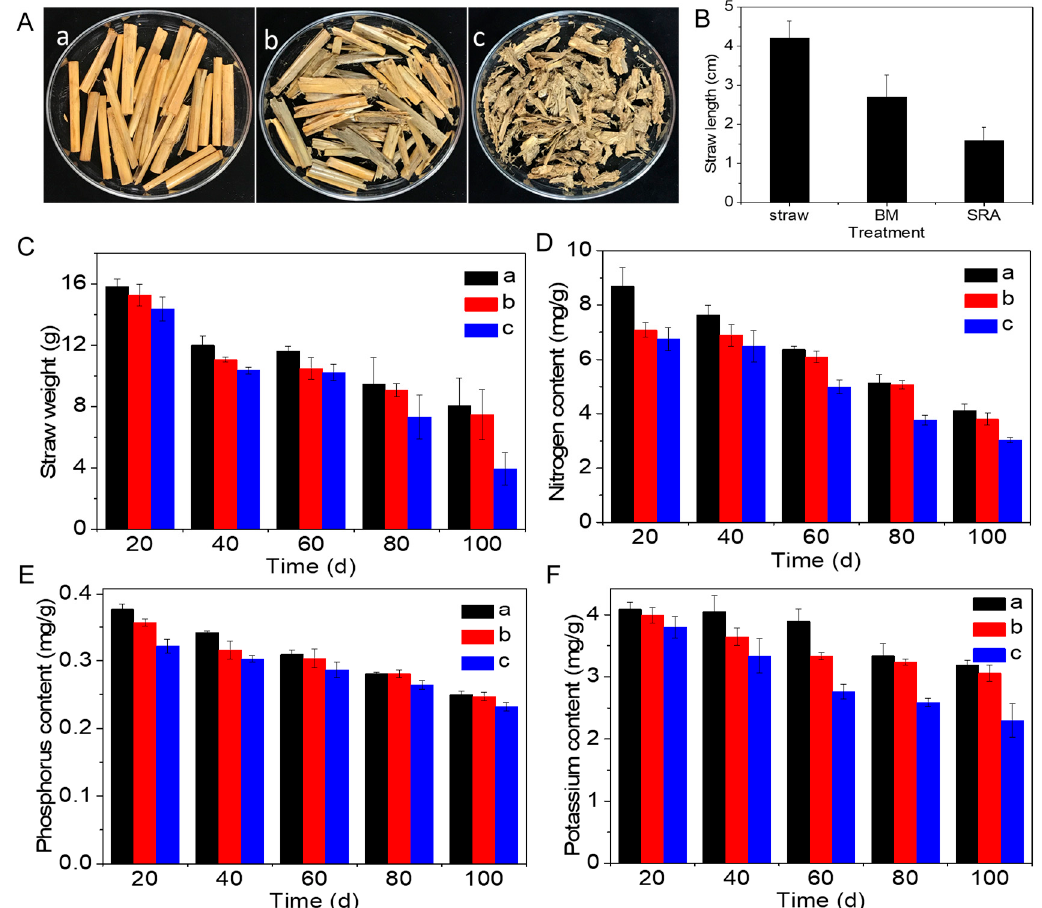
Figure 2. ( A ) Digital photographs of ( a ) wheat straw alone and those treated by ( b ) bacterial mixture (BM) and ( c ) straw returning agent (SRA) for 100 d. ( B – F ) Length, weight, nitrogen, phosphorus, and potassium contents of the resulting straws.